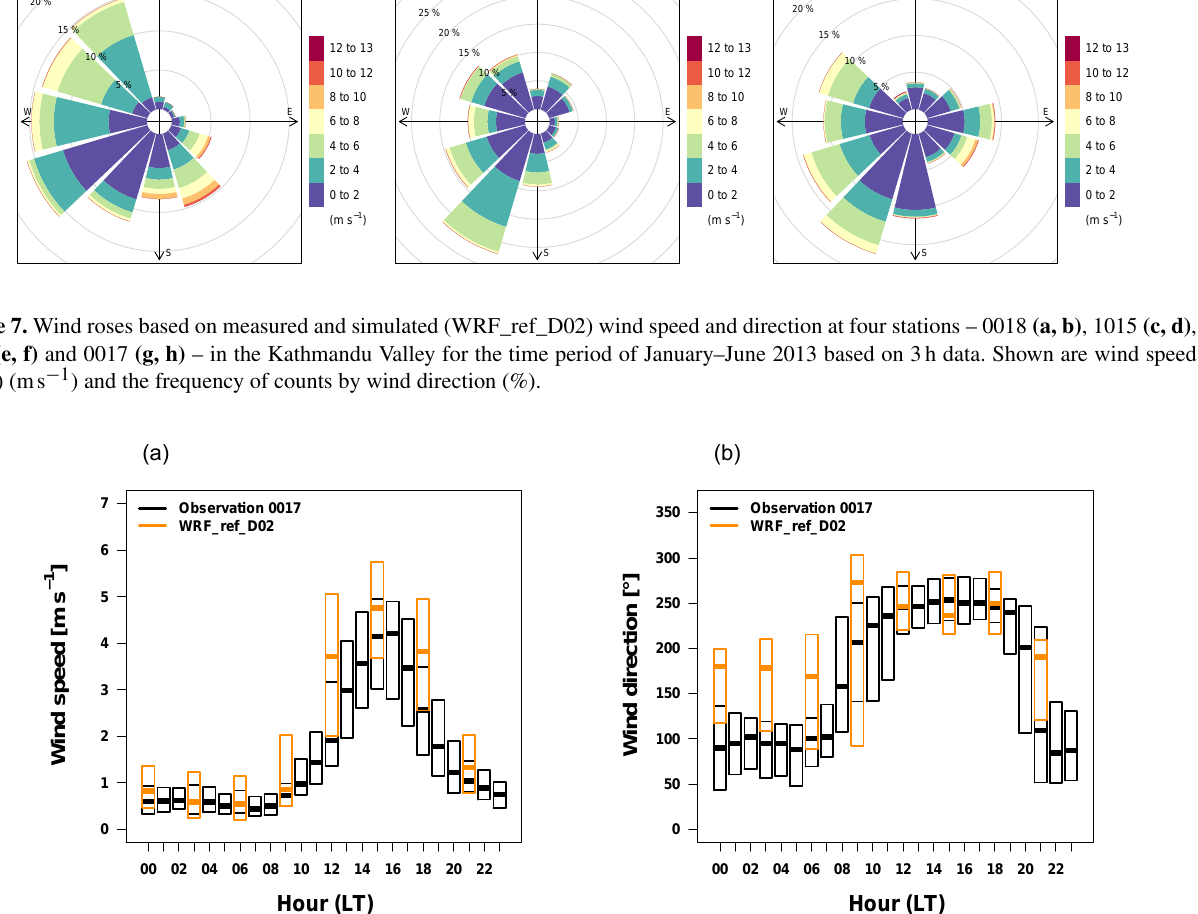
son which is shown in Fig. 11 for May shows rain rates be- tween 6 and 15 mmday − 1 particularly over Nepal, and rain rates between 0 and 5 mmday − 1 over northern India and the part of the Tibetan Plateau covered by model domain